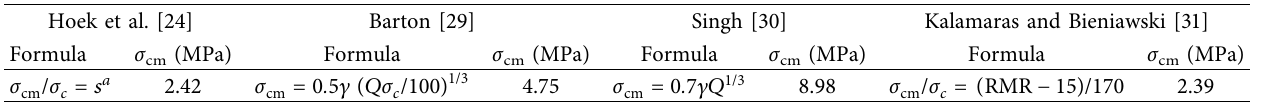
Table 13: Estimation results of rock mass strength.